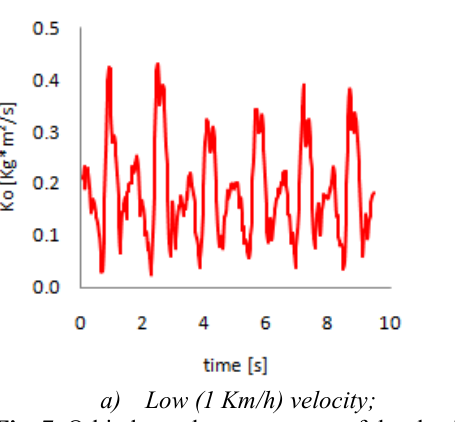
Fig. 7. Orbital angular momentum of the shank.